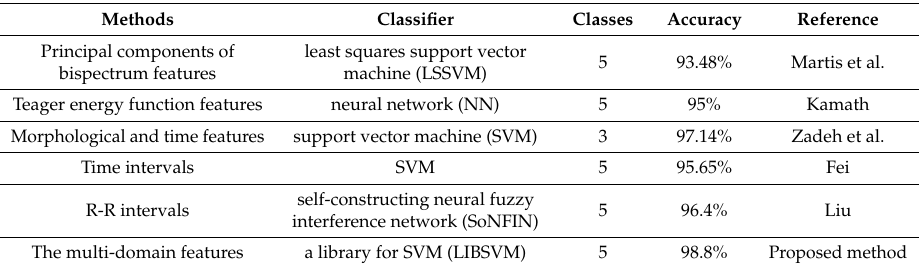
Table 6. Comparison results of the proposed system with other